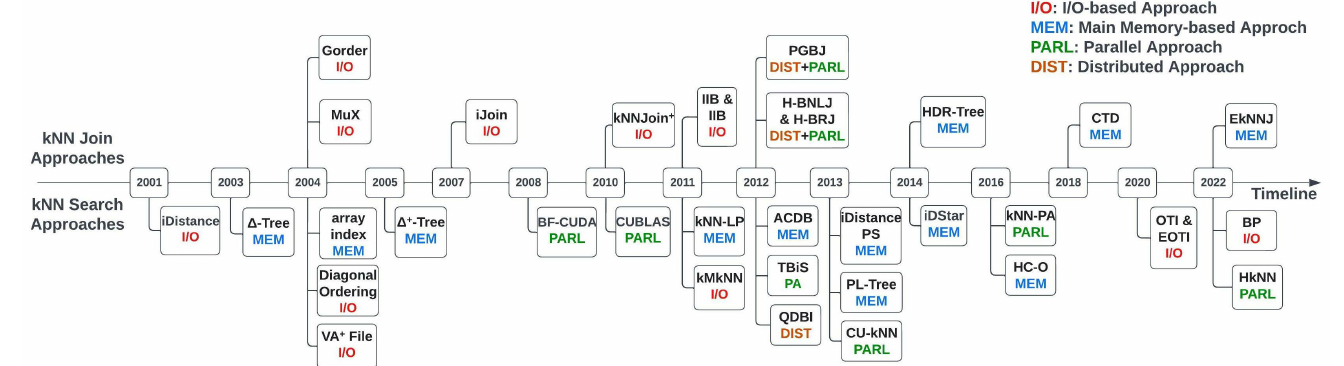
Figure 3. Timeline of kNN Join and kNN Searching techniques.